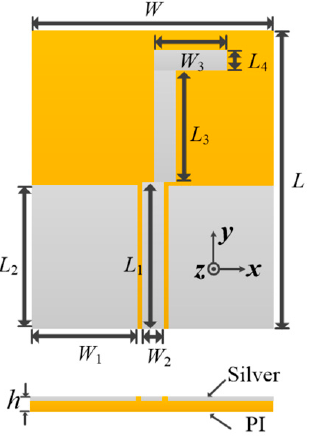
Figure 1. Schematic view of the proposed antenna.